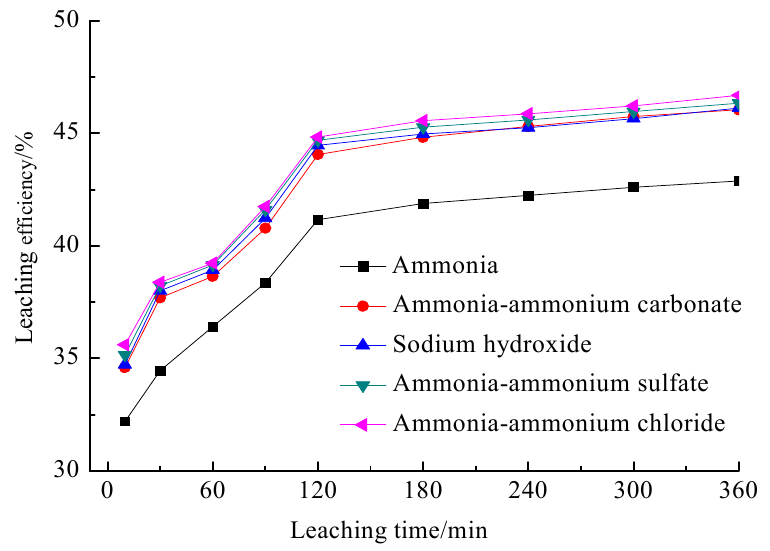
Figure 2. Effect of leaching time on the leaching efficiency of zinc in different lixiviants. As noted in Section 2.1, zinc exists in the gossan ores in the form of siderite, limonite, and smithsonite. The present results suggest that zinc in smithsonite can be dissolved in the leaching solution, whereas zinc in limonite can be partly desorbed under external forces. Zinc in siderite cannot be recovered due to its solubility in the leaching agent. Therefore, it can be concluded that it is difficult to recover zinc from gossan ore via this alkaline leaching method.